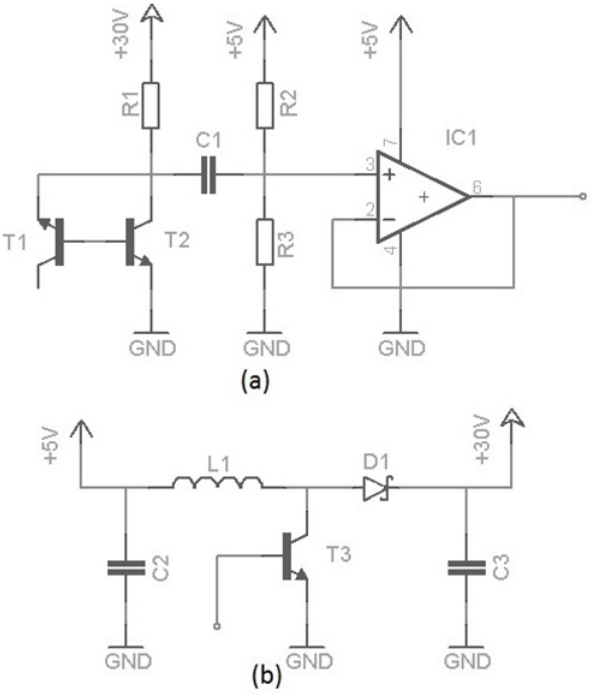
Fig. 8. Noise generator circuit (a) and boost converter